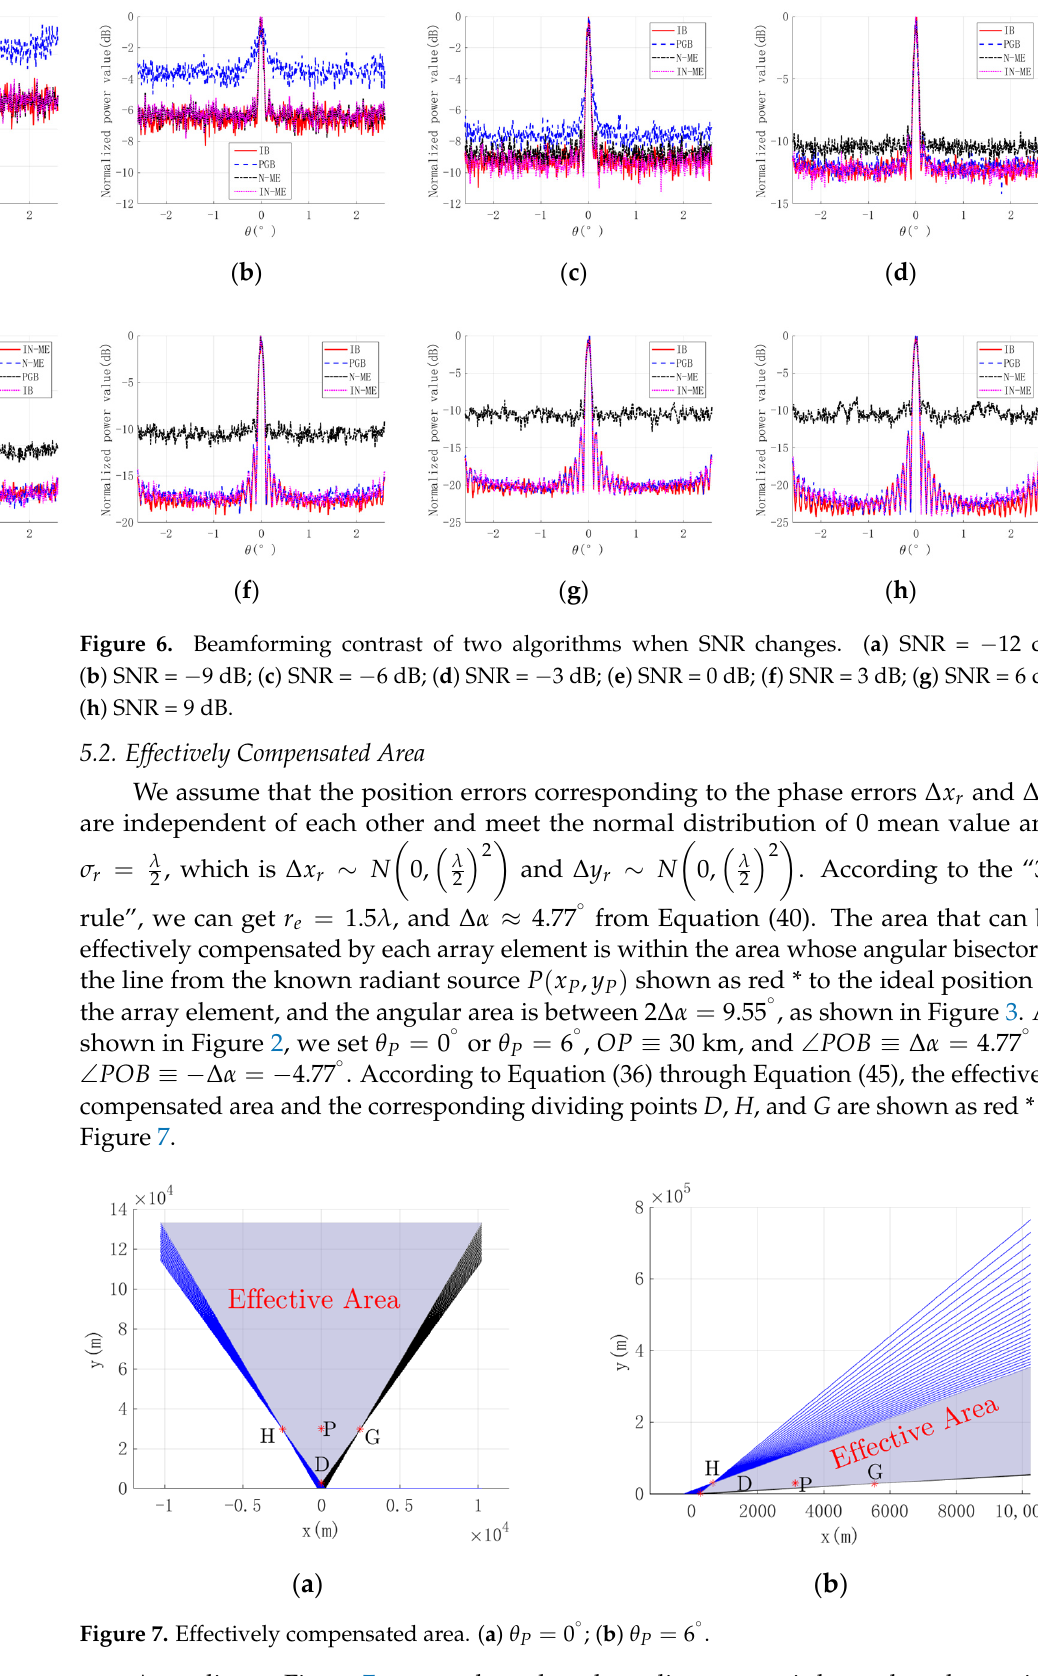
( b ) Figure 8. Change of main-lobe power within the effectively compensated area; ( a ) moving radiant source M trajectory; ( b ) variation of main-lobe power value with M x .